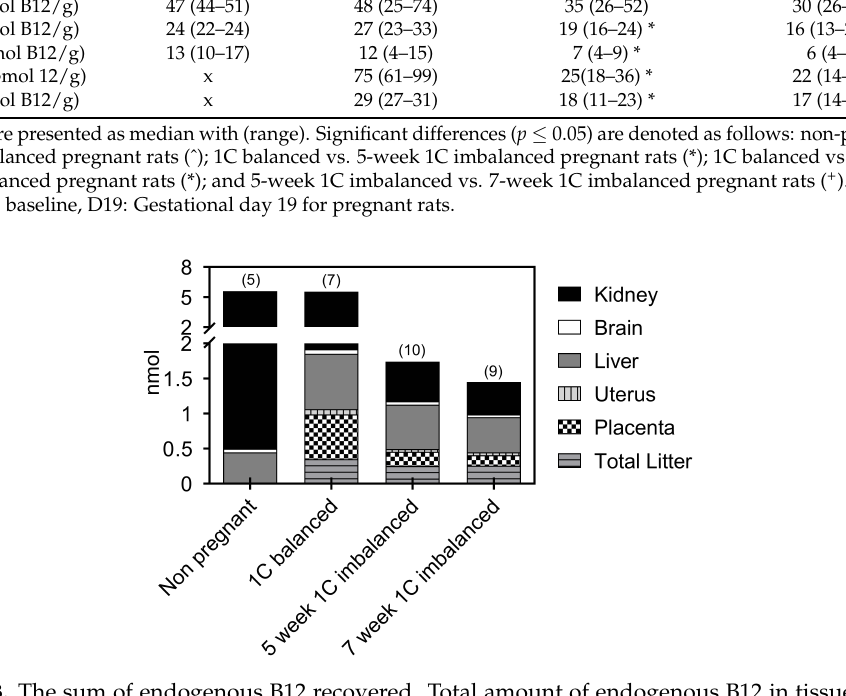
Figure 3. The sum of endogenous B12 recovered. Total amount of endogenous B12 in tissues from non-pregnant 1C balanced rats and from 1C balanced and 1C imbalanced pregnant rats at gestation day 19. The amount of B12 in each tissue was calculated by multiplying B12/g and the total organ weight. Results are given as stacked mean values (pmol). Number ( n ) of animals in each column is shown in